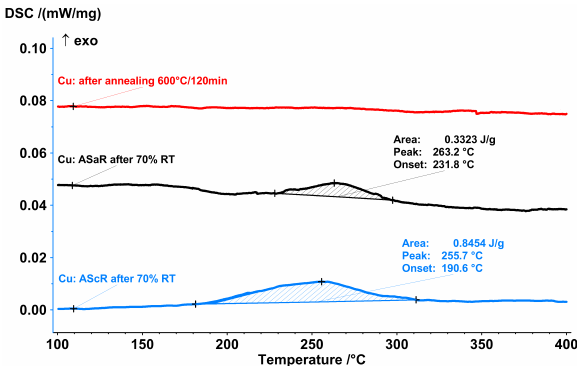
Figure 3: DSC curves of Cu after processing by annealing, ASaR and AScR.